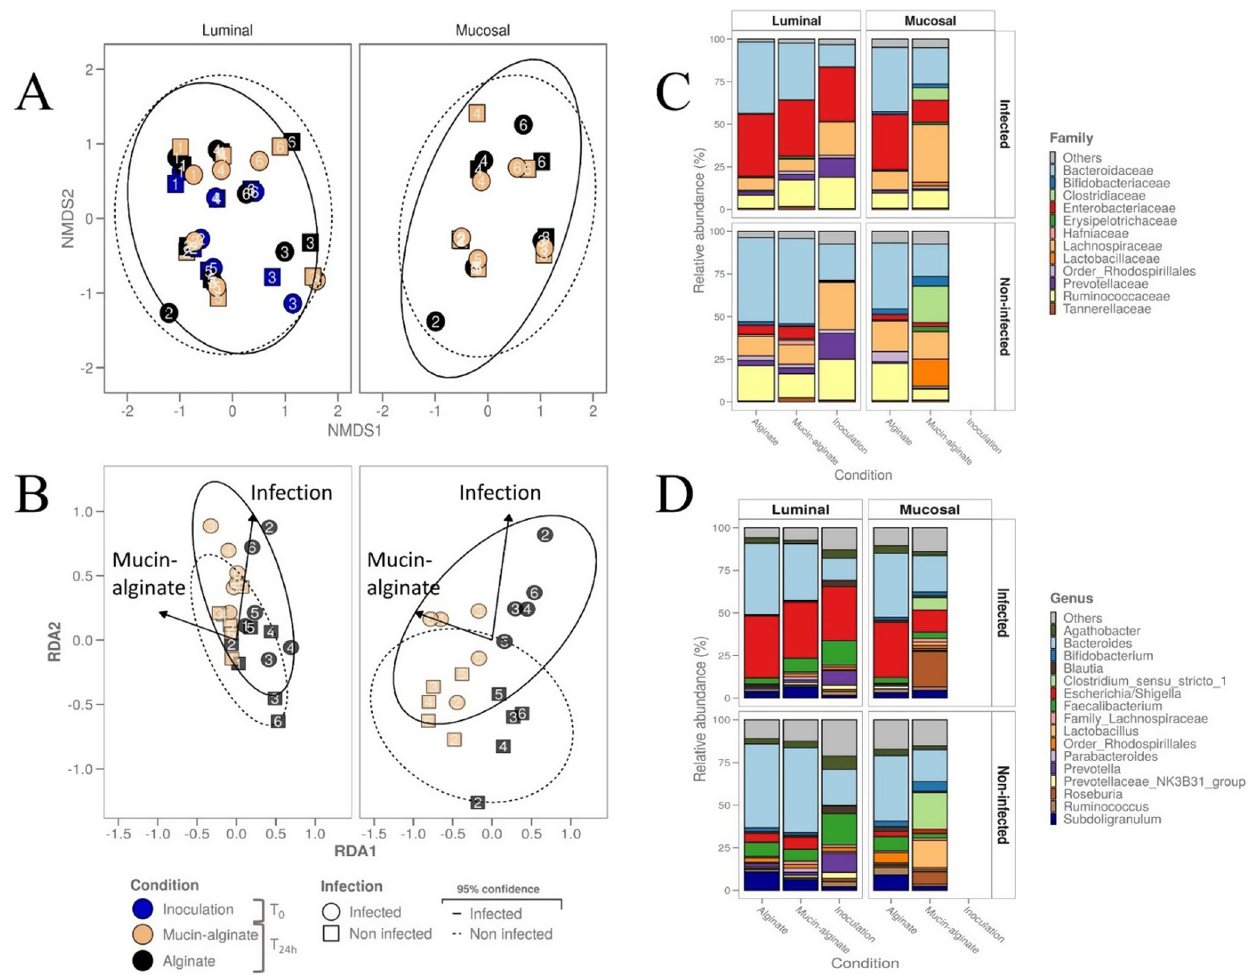
Fig. 7 Impact of mucin on ETEC modulation of fecal microbial communities as determined by β -diversity. Batch experiments were performed using feces from 6 healthy donors, challenged or not with ETEC strain H10407, with mucin-alginate beads or alginate beads (as a control). A Non-metric multidimensional scaling (NMDS) and ( B ) distance-based redundancy analysis (db-RDA) two-dimension plot visualization report the microbial community β -diversity at the ASV level, as determined by 16S rRNA gene amplicon sequencing. For db-RDA, ASV1 (attributed to Escherichia / Shigella genus) was excluded from the relative ASV table and “ infection ” and “ mucin ” were provided as sole environmental variables (binary) and plotted as vectors (arrows). Blue, black and orange dots represent individual biological replicates (donor numbers are indicated) at the beginning of the experiment (inoculation, T0) or after 24 h of fermentation (T24h) with alginate and mucin- alginate beads, respectively. Samples are represented by dot shape and square shape for the infected and non-infected conditions, respectively. The 95% con fi dence ellipse area is also indicated in continuous line for the infected condition and in dotted line for the non- infected condition. Cumulative bar plots of the relative microbial community composition at the family ( C ) and genus ( D ) levels. The area graphs show the relative abundance of the 12 most abundant families and 16 most abundant genera with all six different donors